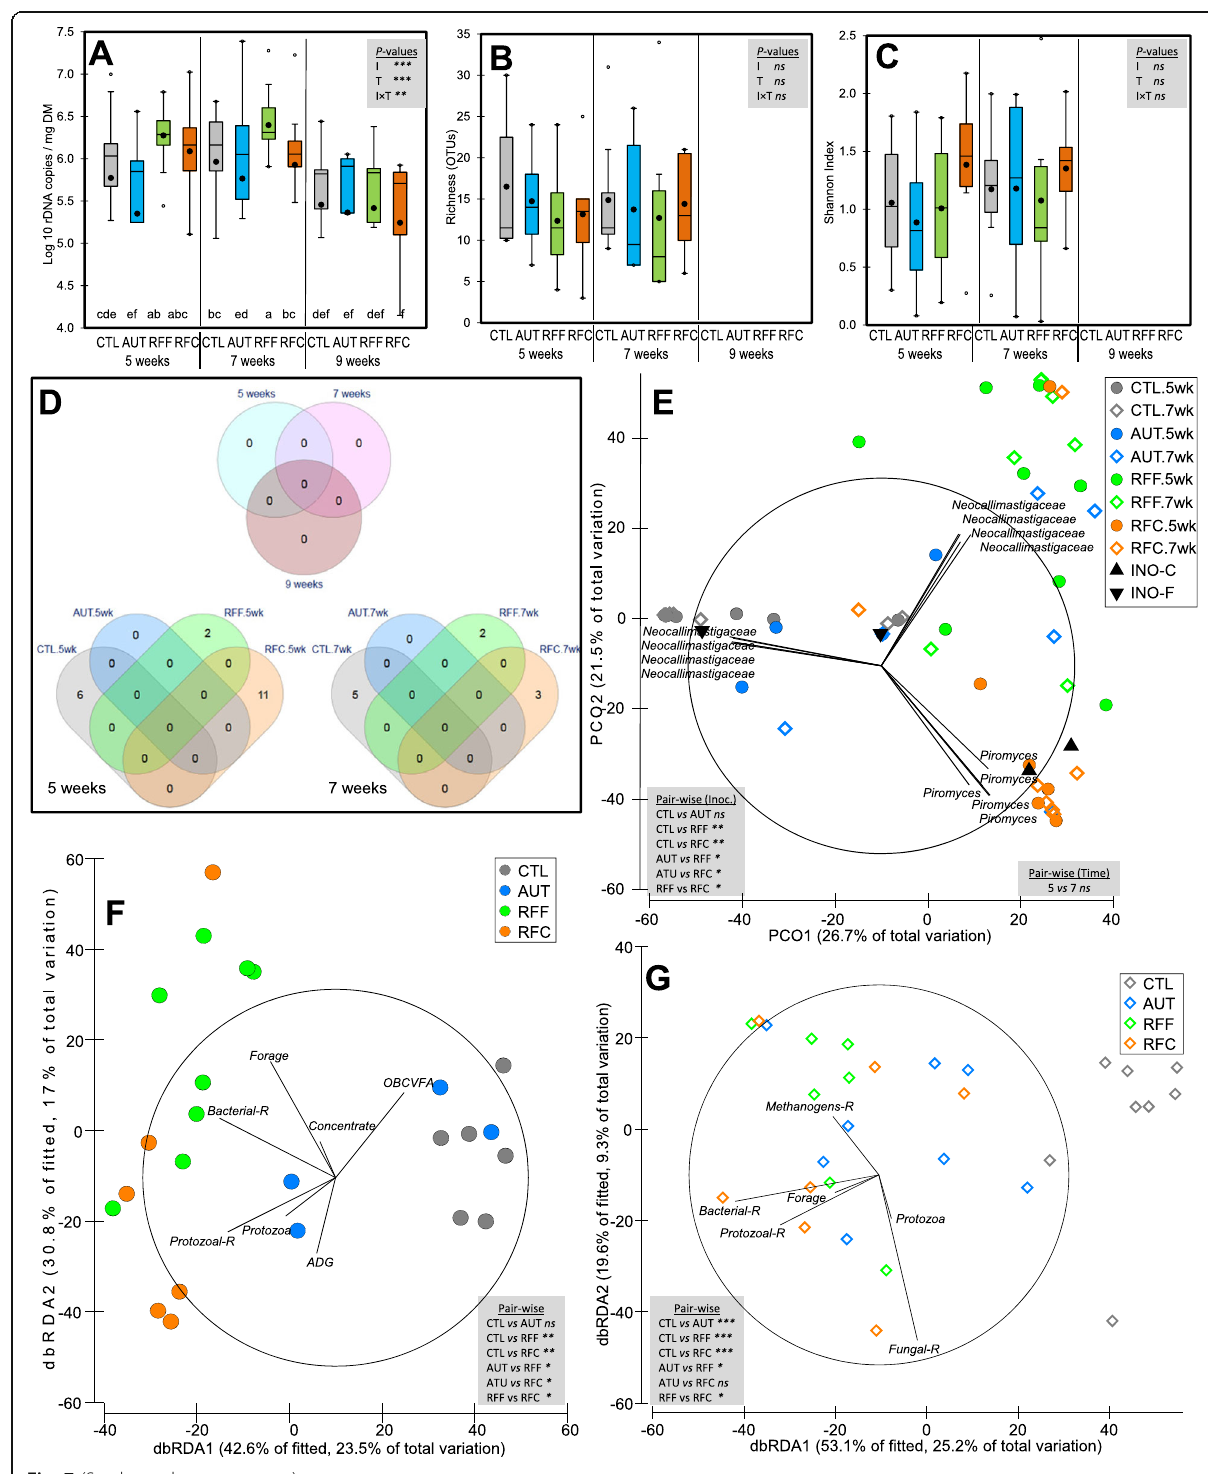
Fig. 7 (See legend on next